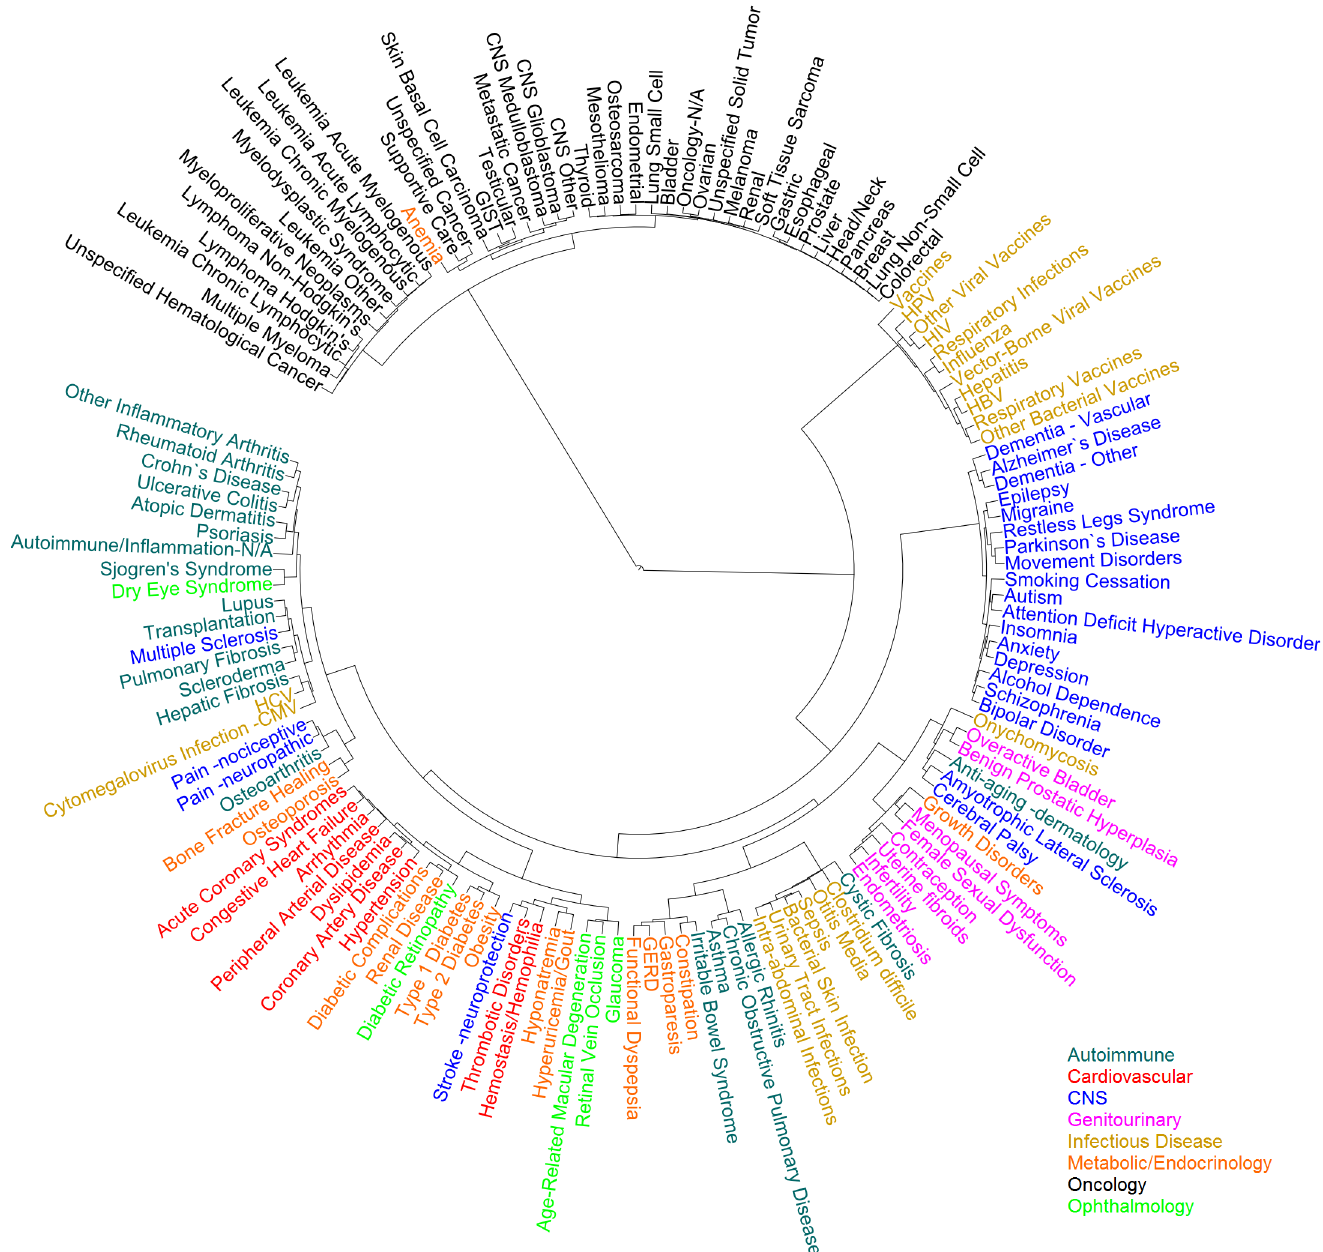
Fig 6. Drug-centric hierarchical clustering of diseases. One hundred forty-one diseases from the Trial dataset were clustered using a distance metric based on the drugs adopted by each disease. The Trial manually-created classification included the categories: autoimmune/inflammation (blue-green), cardiovascular (red), CNS (blue), genitourinary (pink), infectious disease (gold), metabolic/endocrinology (orange), oncology (black), ophthalmology (green).